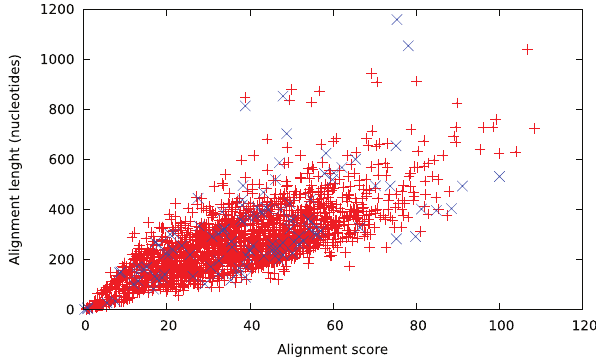
Figure 7. Alignments lengths resulting from transitive align- ments divided by the corresponding score for the best direct alignment. The plot shows median, quartiles, and 10- and 90- percentile length ratios, for the best transitive alignment (blue), and for the best transitive alignment with the same gene symbol as the best direct alignment (red).